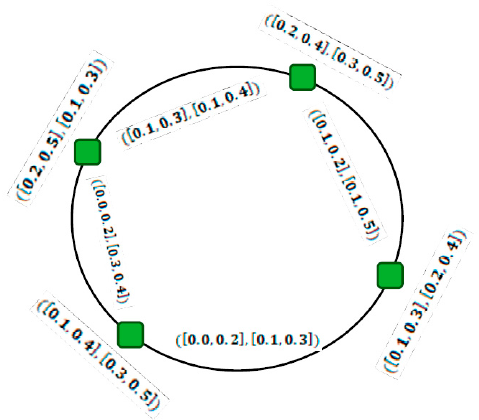
Figure 15. Complement of IVIFG depicted in Figure 14.